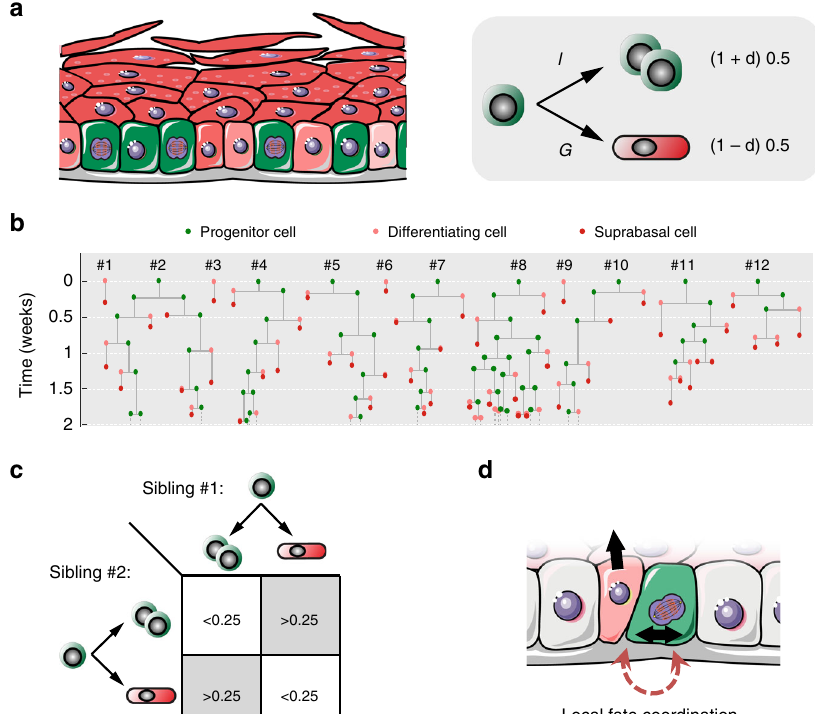
Fig. 9 Cell fate coordination underpins single-progenitor dynamics in epidermis and esophagus. a Epidermis and esophageal epithelium are maintained by a single population of progenitor cells. Left panel: Progenitor cells (in green) share the basal layer with post-mitotic keratinocytes in early stages of differentiation (pale red), which are transiently retained in the basal compartment before strati fi cation. Right panel: Simpli fi ed representation of the single- progenitor model focusing on individual basal cell fates. Epithelial cell dynamics are dominated by stochastic but skewed fates through spatial coordination between neighboring or sibling cells. Individual basal cells undertake dichotomic decisions: they have the potential to divide but can alternatively differentiate exiting the basal layer. Both probabilities are balanced (50 – 50%) across the entire proliferating cell population, but can be decompensated or skewed